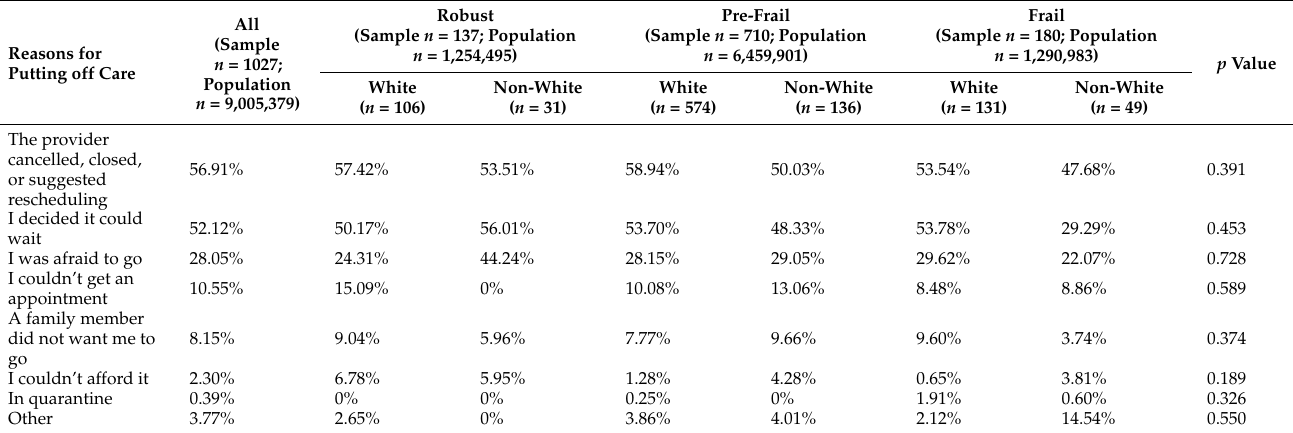
Table 4. Reasons for putting off care by frailty and race/ethnicity.